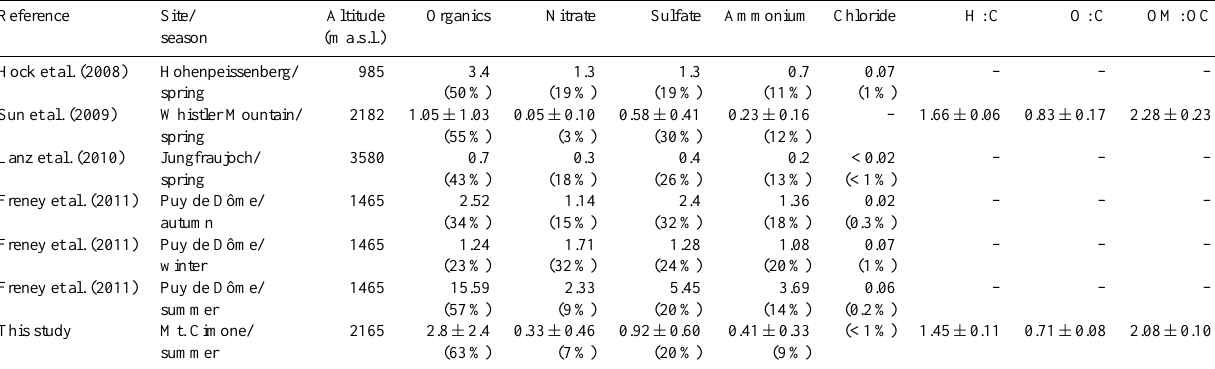
Table 1. Summary of AMS measurements at mountain sites published in the literature. Concentrations are expressed in µgm − 3 . Reference Site/ Altitude